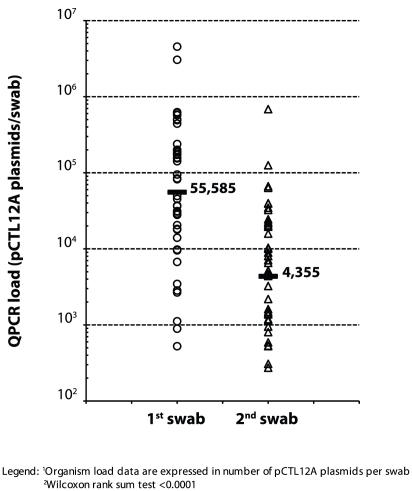
Distribution of the organism load1 in first and second
swabs showing the geometric mean2.